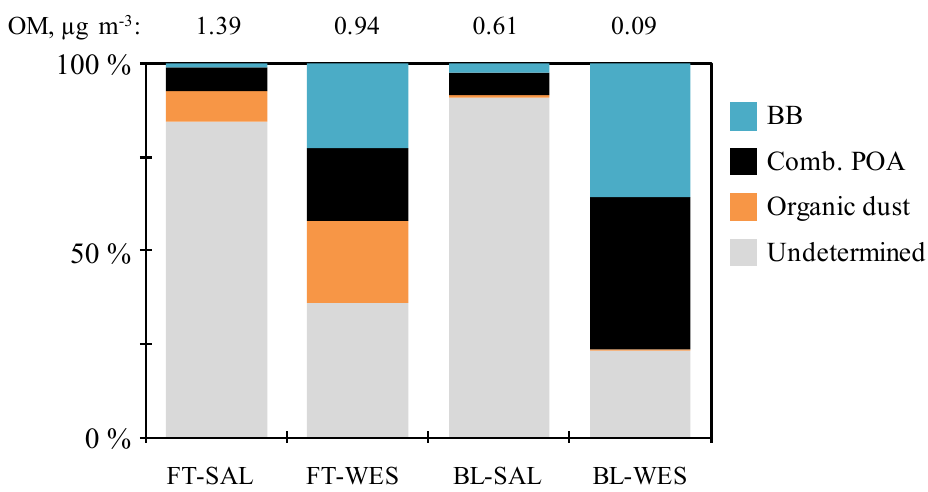
Figure 7. Contribution of the identified organic aerosol sources to the total organic matter within the FT and the BL under the SAL (FT-SAL and BL-SAL) and the WES (FT-WES, BL-WES, BBE). Average total OM for each air mass is at top. FT-PM T samples were collected during the night (22:00–06:00GMT) and BL-PM 2 . 5 samples were collected during the day